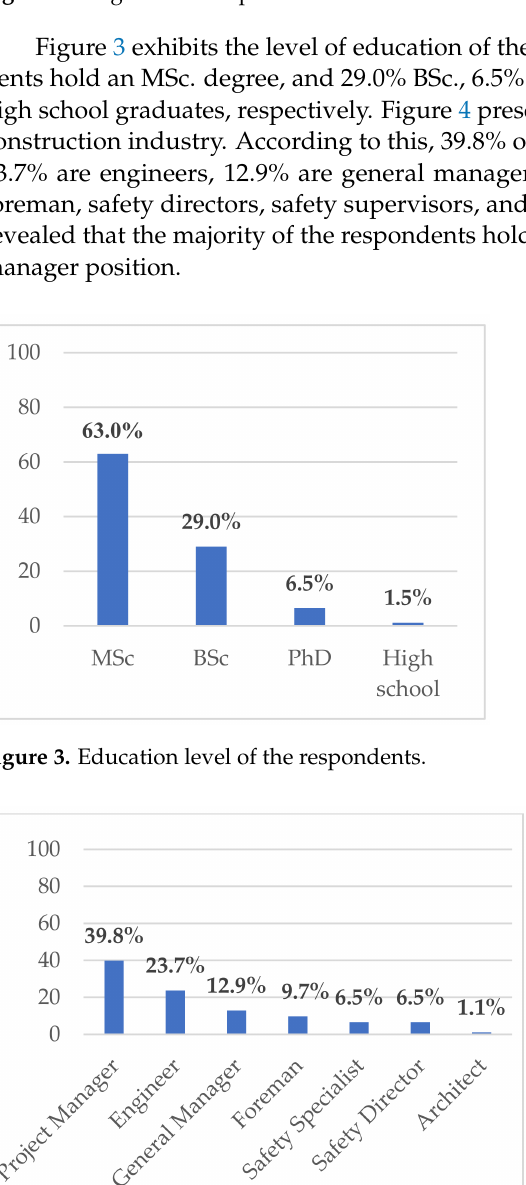
Figure 2. Origin of the respondents.